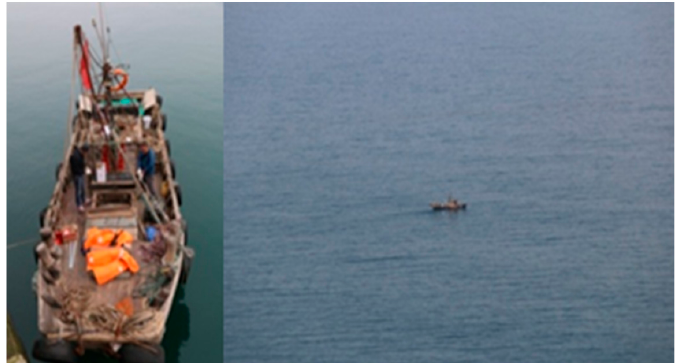
Figure 1. Live map of the cooperative fishing boat on the sea surface.